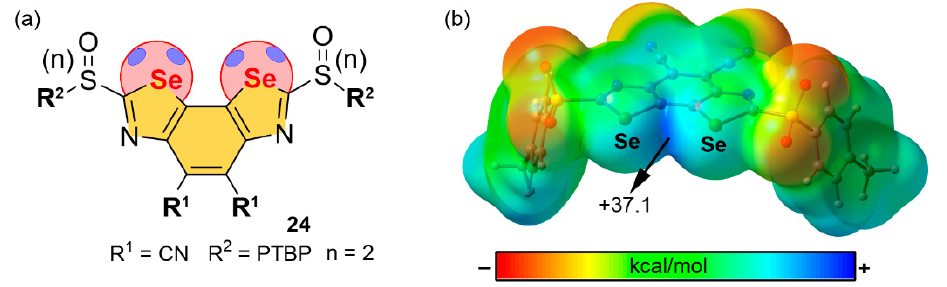
Figure 13. ( a ) Schematic representation of compound 24 (PTBP stands for para -tercbutylphenyl) and ( b ) its MEP surface at the B3LYP/def2-TZVP level of theory. The energy value at the selected point of the surface is given in kcal/mol (0.001 a.u.).